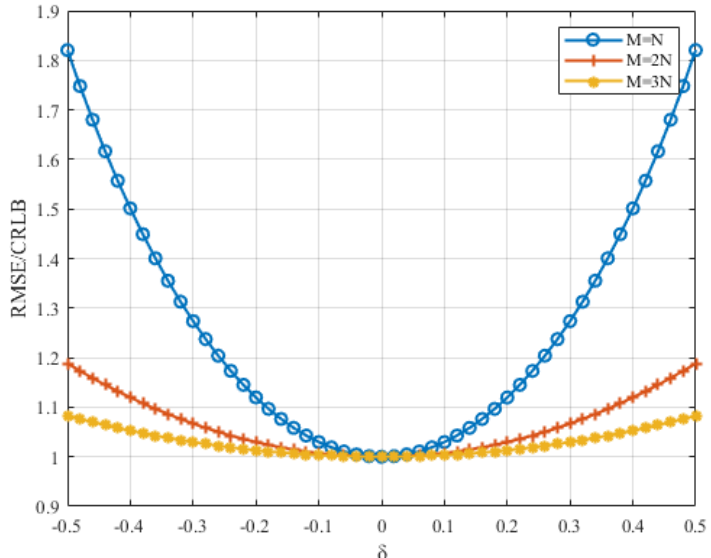
Figure 4. The RMSE/CRLB of the proposed estimator versus δ at different values of M when SNR = 0 dB and N = 512.